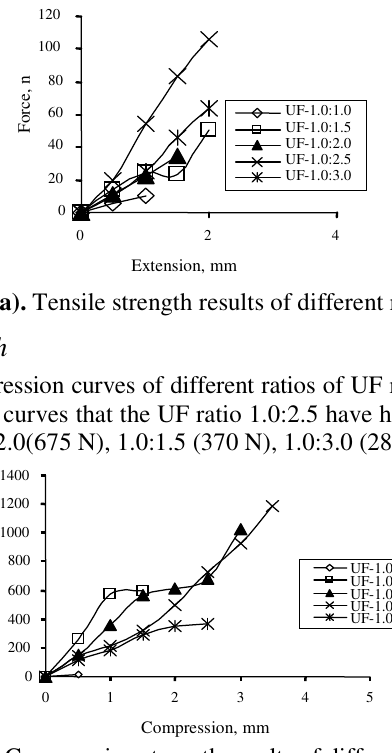
Figure 1(b). Compressive strength results of different ratios of UF